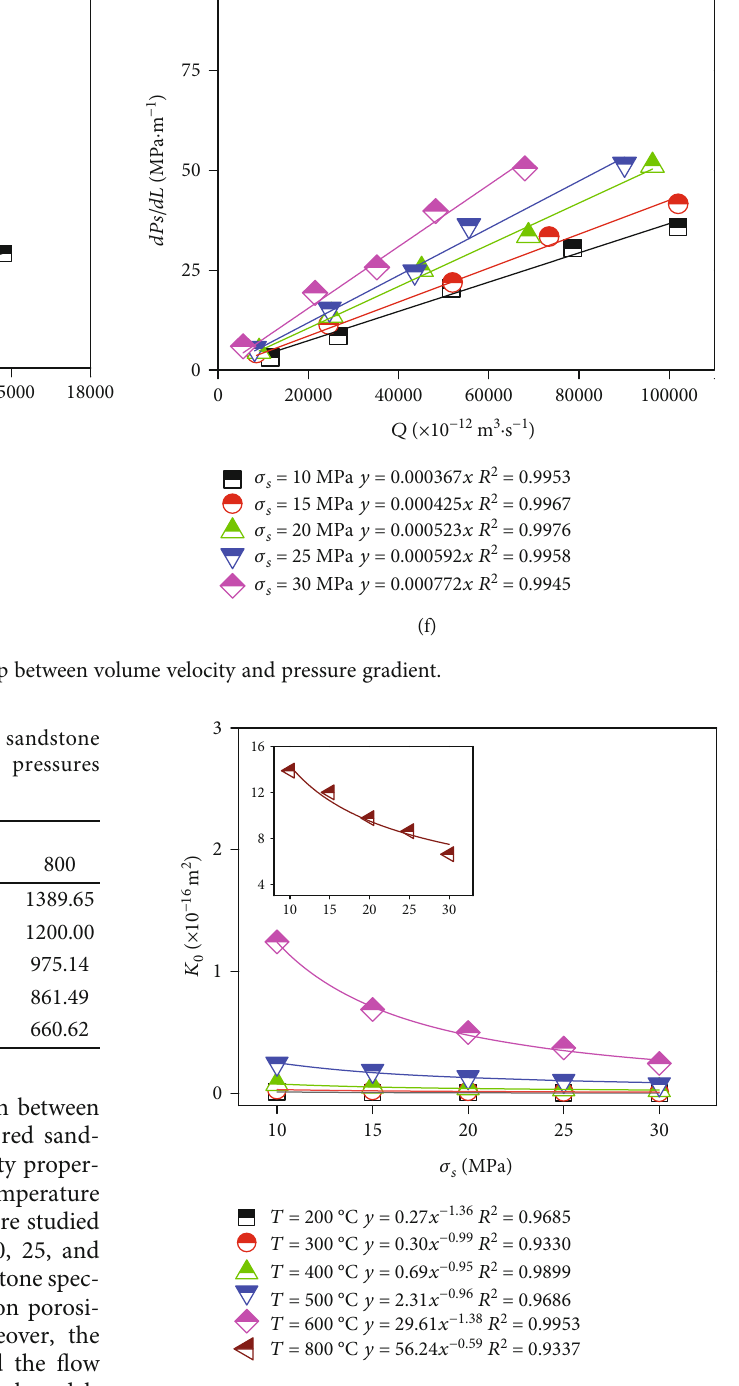
Figure 4: Relationship between equivalent permeability coe ffi cients and con fi ning